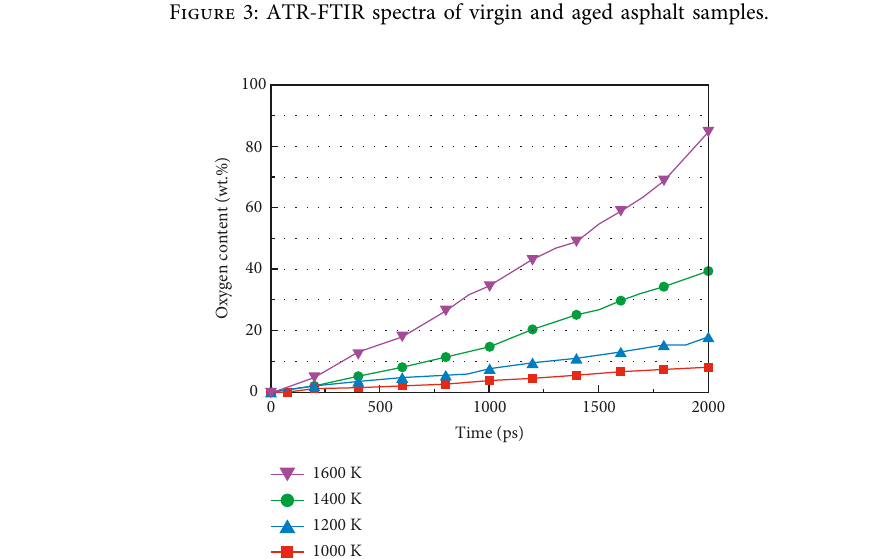
Figure 4: Oxygen content of base asphalt at various temperatures observed from ReaxFF MD simulations.